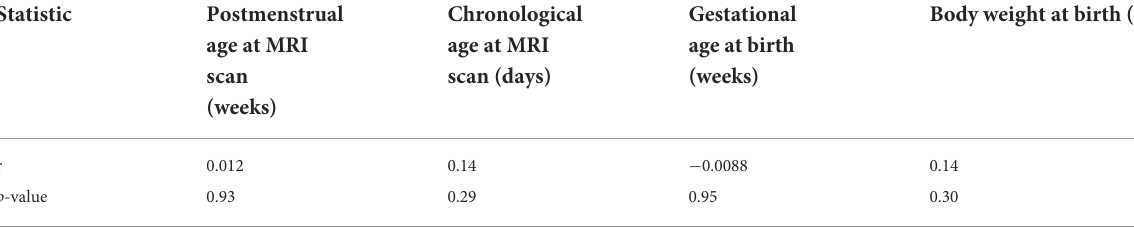
TABLE 6 Pearson’s correlation coefficients and p -values between the cDTI score and the continuous clinical variables.